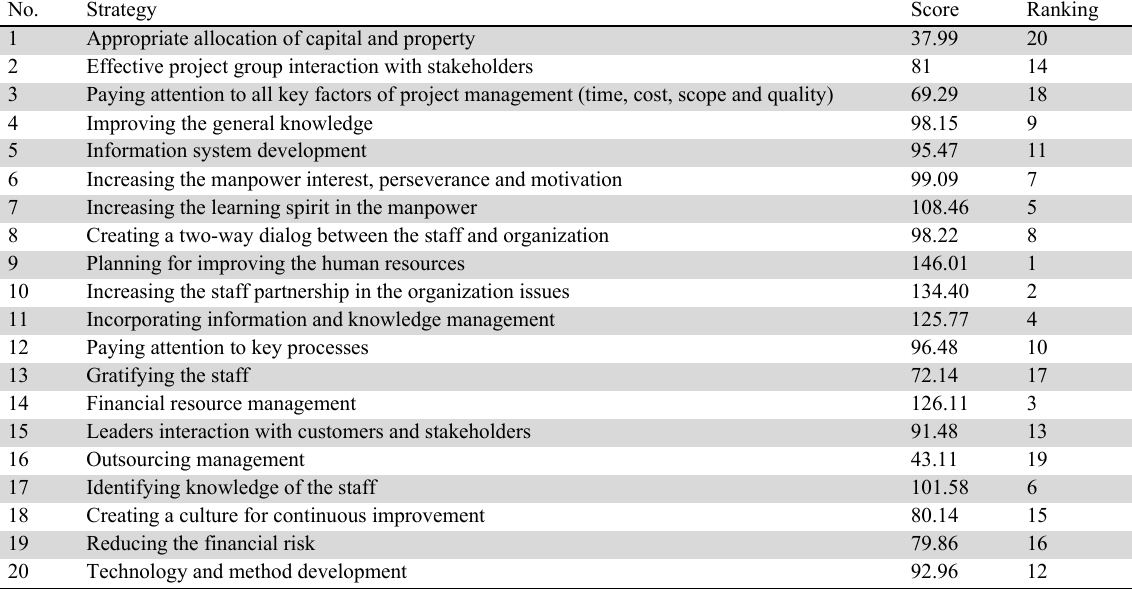
Strategies obtained from quality